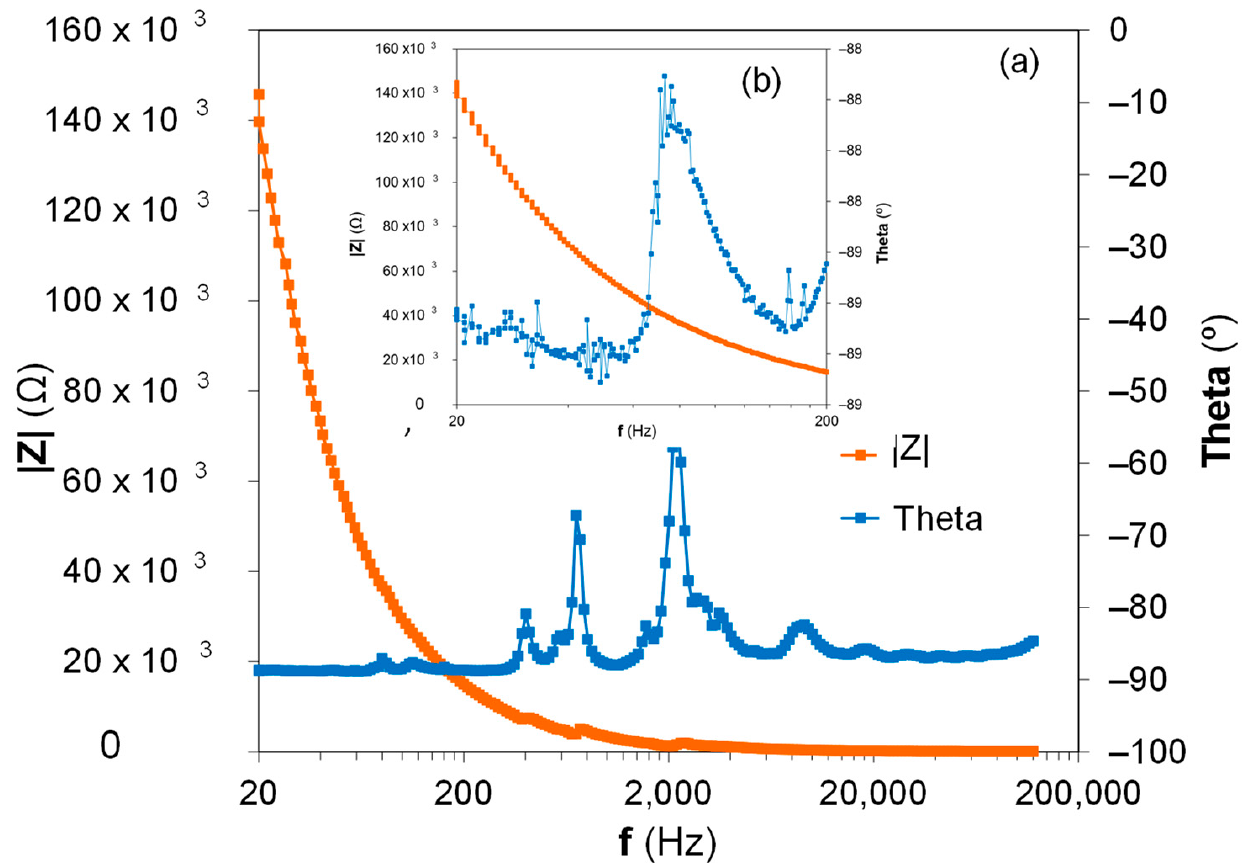
Figure 2. Impedance characterization in the frequency domain for the homemade PIC255 bimorph piezoelectric harvester: ( a ) frequency range from 20 Hz to 120 KHz and ( b ) frequency range from 20 Hz to 200 Hz.